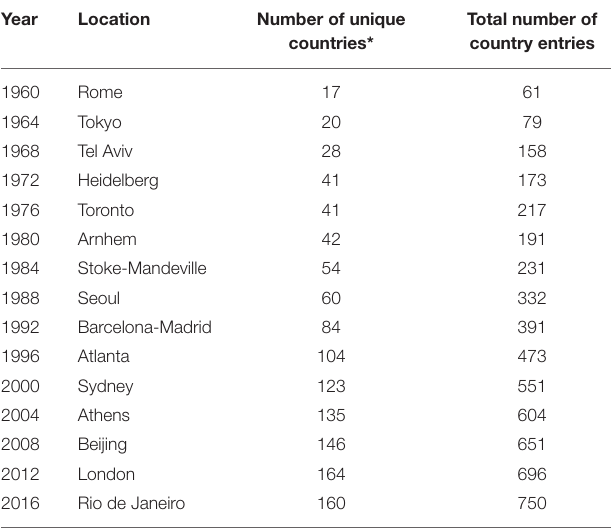
TABLE 2 | Overview of the number of unique countries, and number of countries counted once per sport for each edition of the Paralympic Summer Games. Year Location Number of unique Total number of countries* country